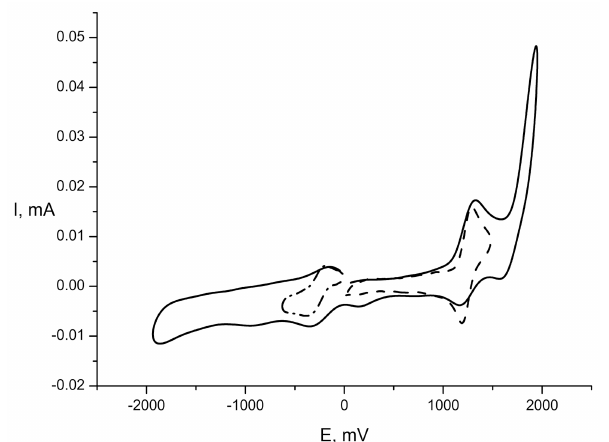
Figure 5. Cyclic voltammogram of complex 16 on the GC electrode (sweep rate 100 mV/s, C = 1 × 10 − 3 M, n-Bu4NBF4, and rel.